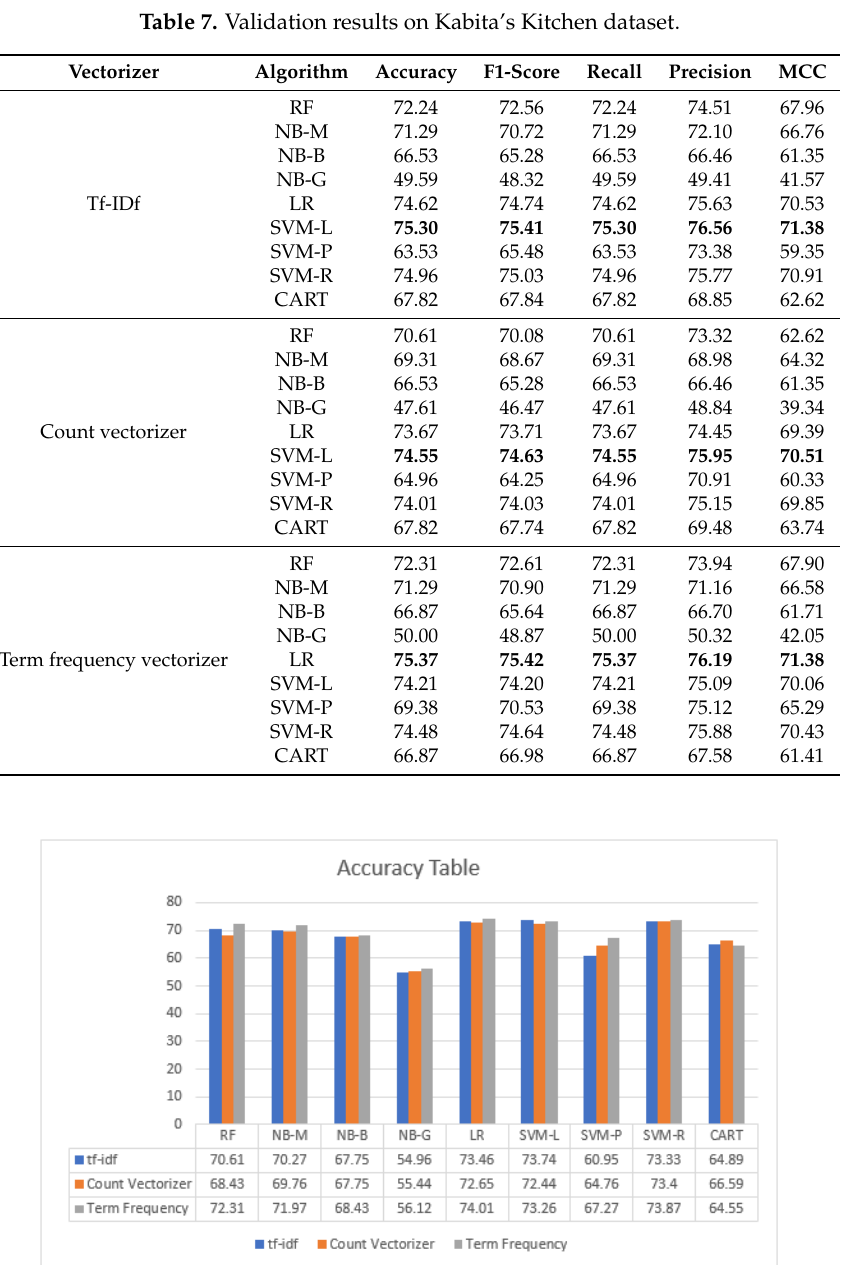
Figure 2. Bar graph showing accuracies on Nisha Madhulika’s dataset using tf-idf, count and term frequency